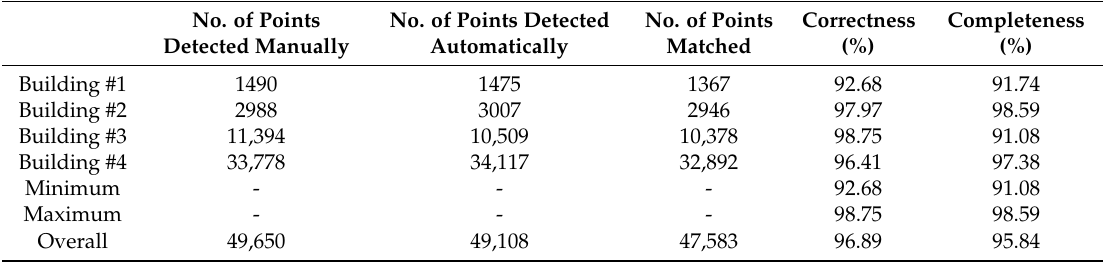
Table 4. Correctness and completeness values of four buildings (Adaptive cylindrical